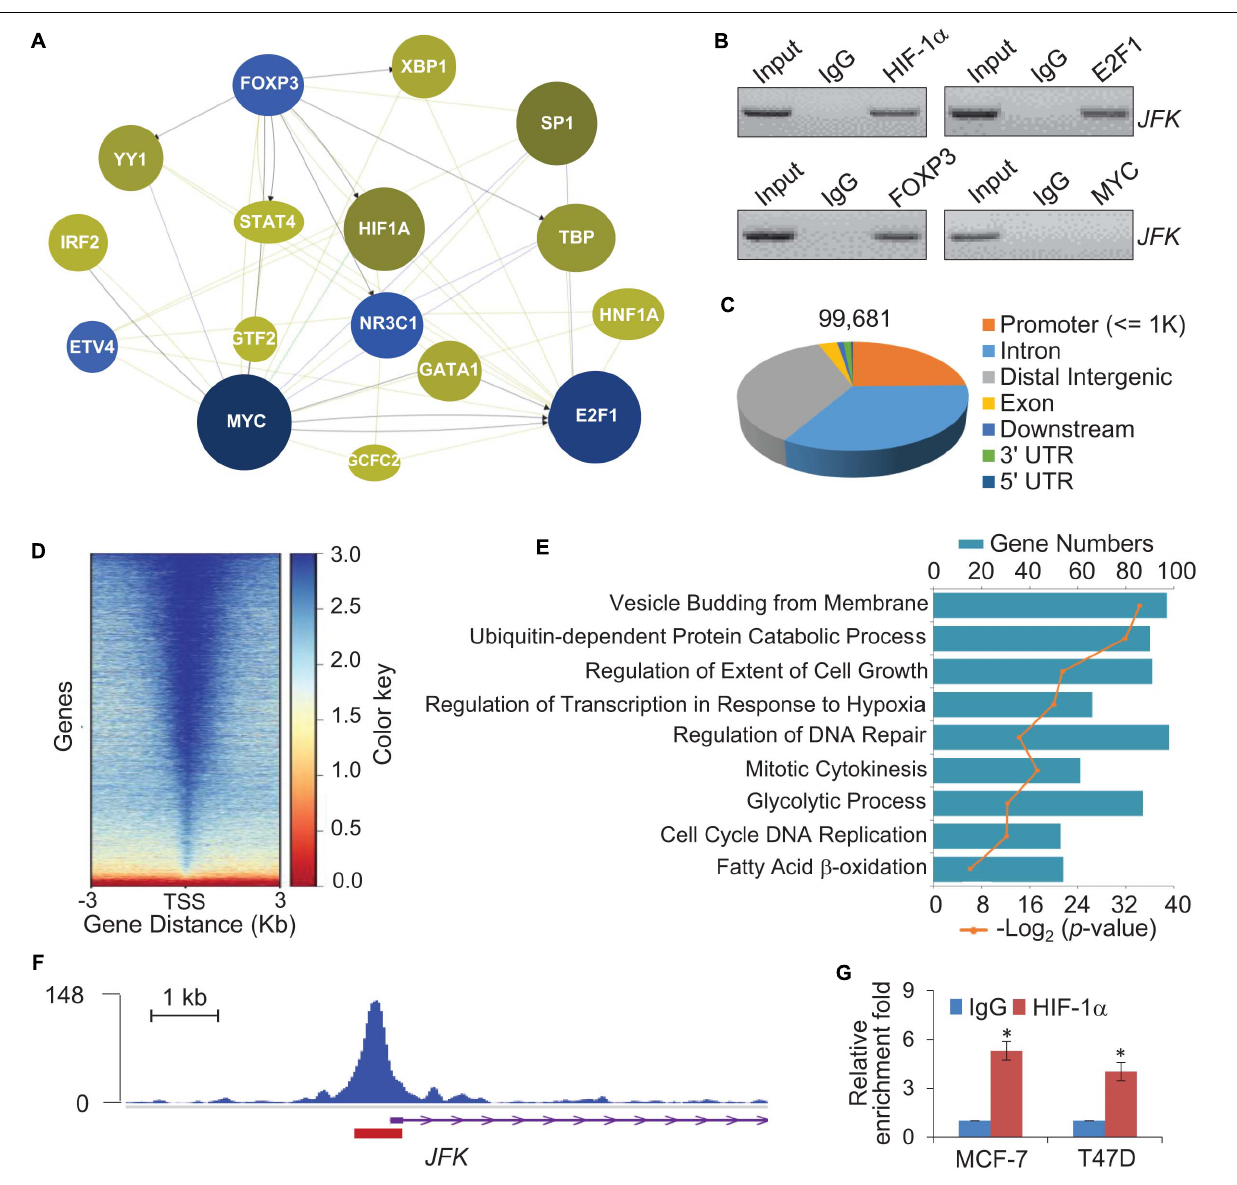
FIGURE 2 | Genome-wide identification of transcriptional targets for HIF-1 α . (A) Breast cancer associated transcription factors which bind at the promoter of JFK were assessed using a Phenolyzer approach. The size and shade of each circle represent the strength of correlation between a given transcription factor that was predicted to bind at the promoter of JFK and breast cancer. (B) Soluble chromatin from MCF-7 cells was prepared for ChIP assays with antibodies against the indicated proteins. (C) Genomic distribution of HIF-1 α determined by ChIP-seq analysis. ChIP was performed in hypoxia-treated T47D cells with antibodies against HIF-1 α , followed by deep sequencing. The raw data were analyzed by MACS2 with a cutoff q value < 1e-2. (D) Binding density of HIF-1 α across its specific binding sites, visualized by deepTools. The heatmap shows the normalized ChIP-seq tag counts ordered by signal strength. (E) GO enrichment (biological processes) analysis of potential target genes. (F) Tracks visualizing the ChIP signal for HIF-1 α binding at representative locus. The red rectangle indicates the peak region/binding site of HIF-1 α at the JFK promoter. (G) qChIP-based verification of HIF-1 α binding at the JFK locus under hypoxia. Soluble chromatin from MCF-7 or T47D cells exposed with hypoxia (1% O 2 ) for 24 h was prepared, and qChIP analysis was performed for the JFK promoter using the antibody against HIF-1 α . Error bars represent the mean ± SD for triplicate experiments. Statistical significance of differences is indicated as * p <